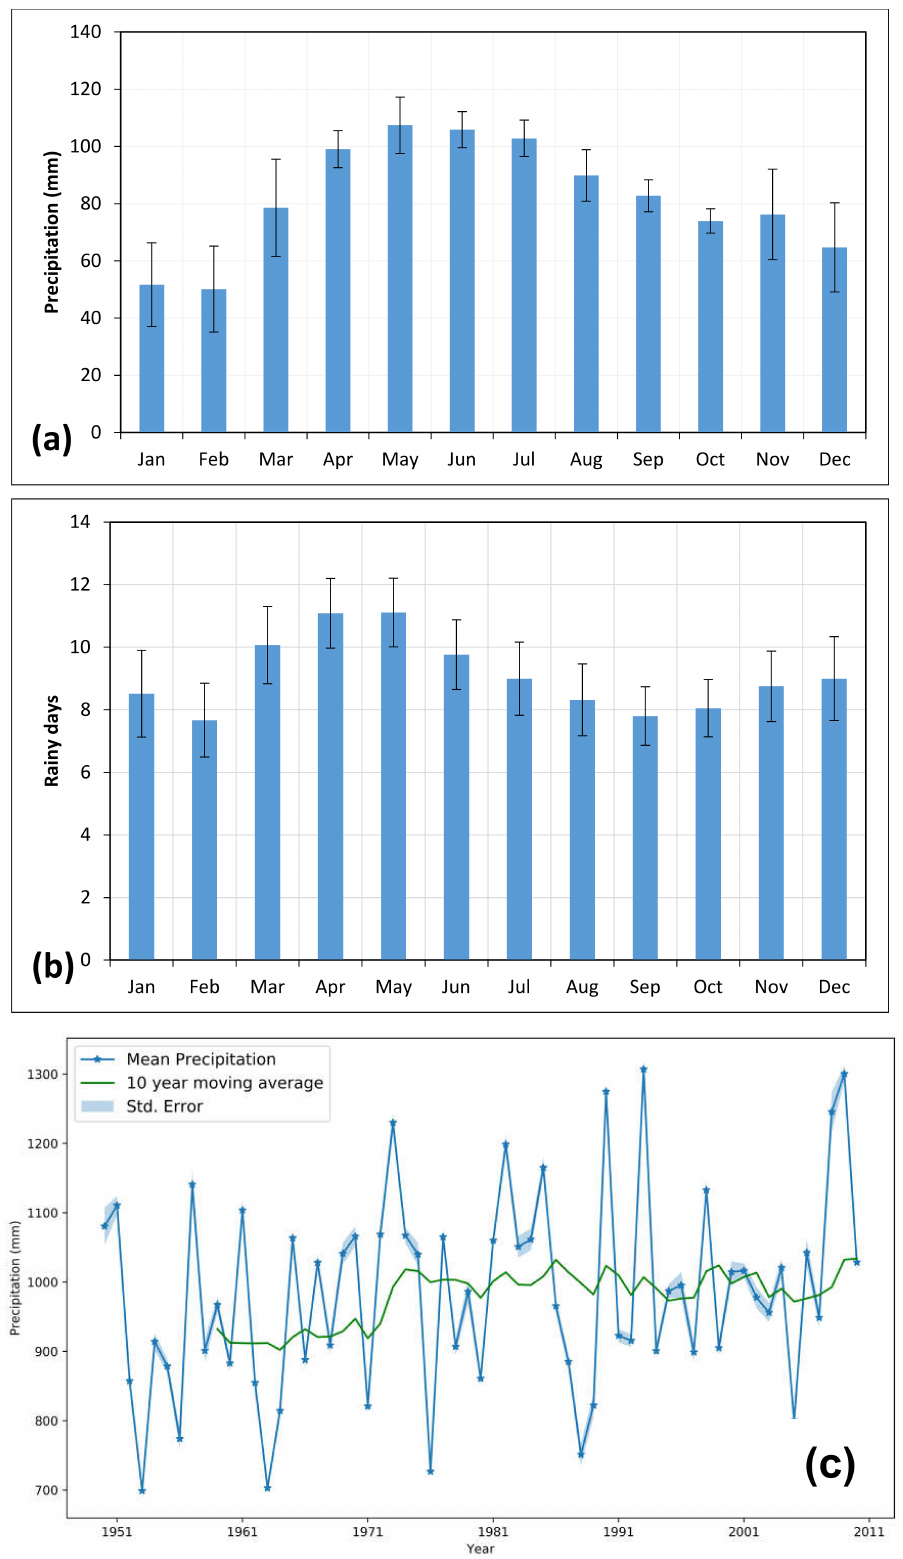
Figure 2. ( a ) Long-term monthly distribution of the area-weighted precipitation amounts, ( b ) monthly distribution of the total number of rainy days for the area-weighted precipitation, and ( c ) spatially averaged precipitation time series of the study area along with the standard error and 10-year moving